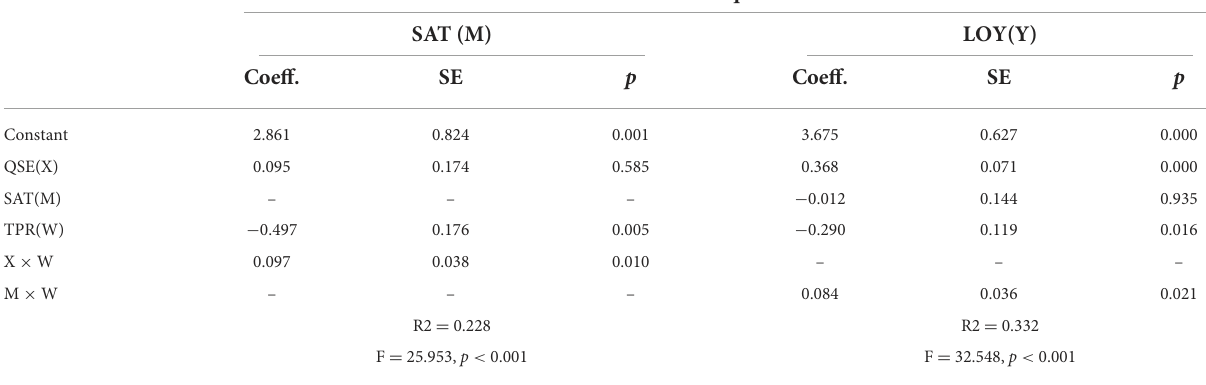
TABLE 8 Moderated mediation model